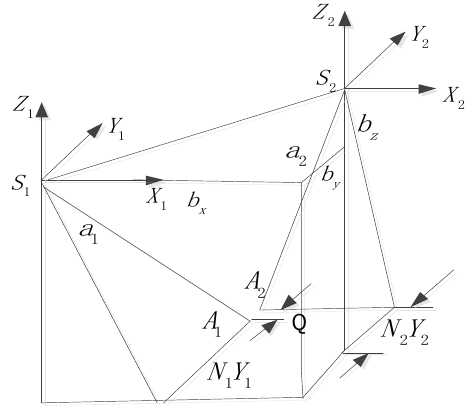
Figure 2. The geometric meaning of parallax